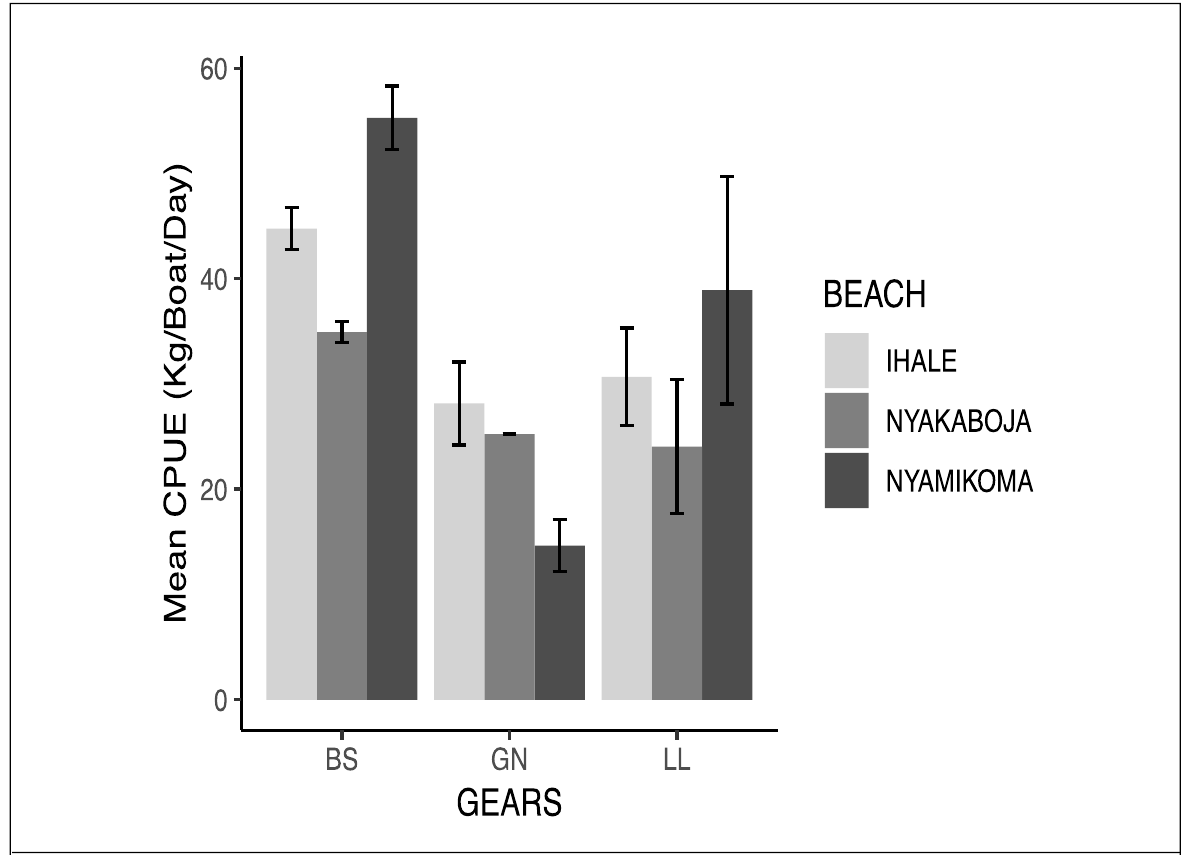
Figure 5: Catch Per Unit Effort (Mean ± sem) of Nile perch caught using beach seine, gillnets and long line fishing gears at Ihale, Nyakaboja and Nyamikoma landing sites at Magu